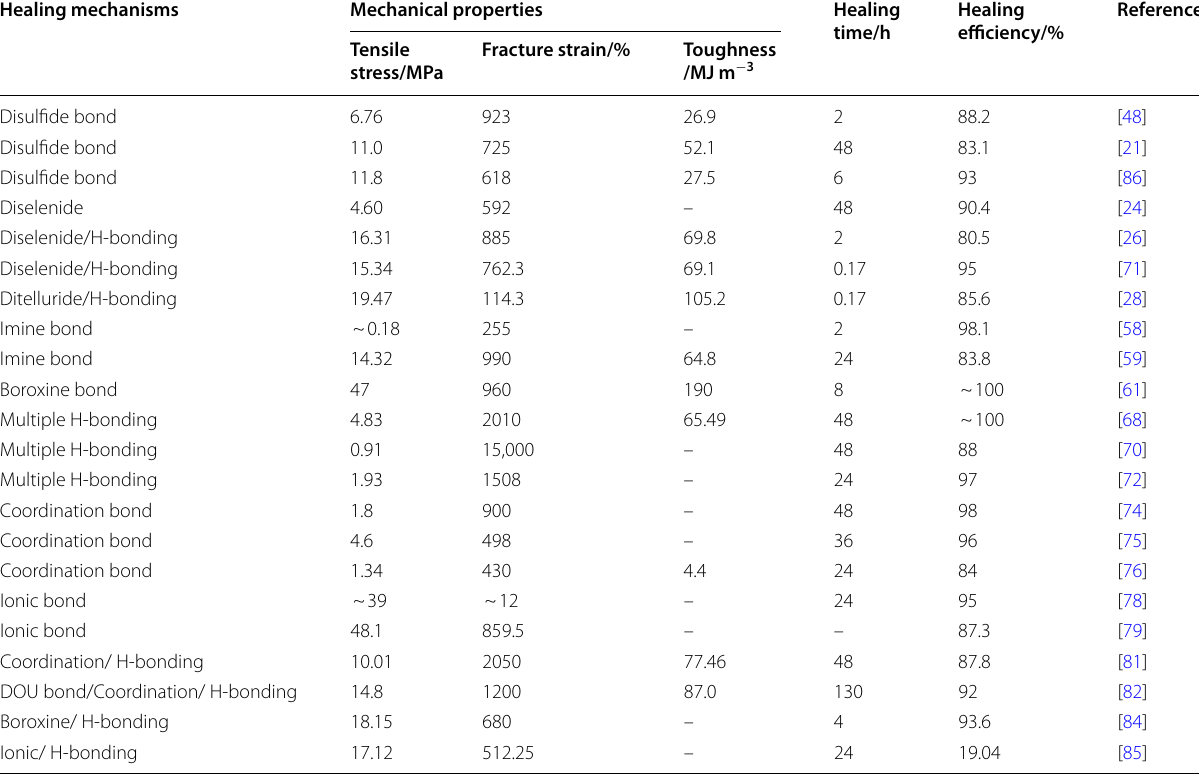
Table 3 Summary of the healing mechanisms, mechanical properties, healing time and healing efficiency of room-temperature self- healing polyurethanes Healing mechanisms Mechanical